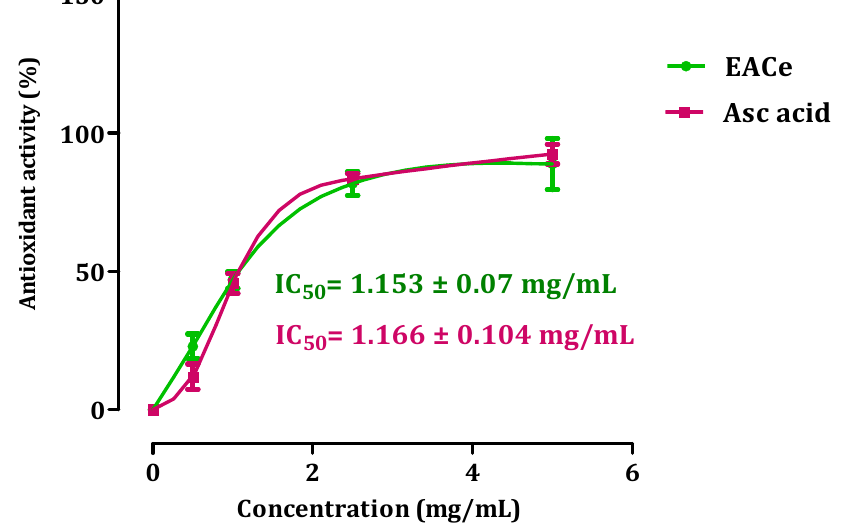
Figure 2. Antioxidant activity of ethyl acetate fraction from C. europaea (EACe). Each value is expressed as mean ± SEM ( n = 3) .